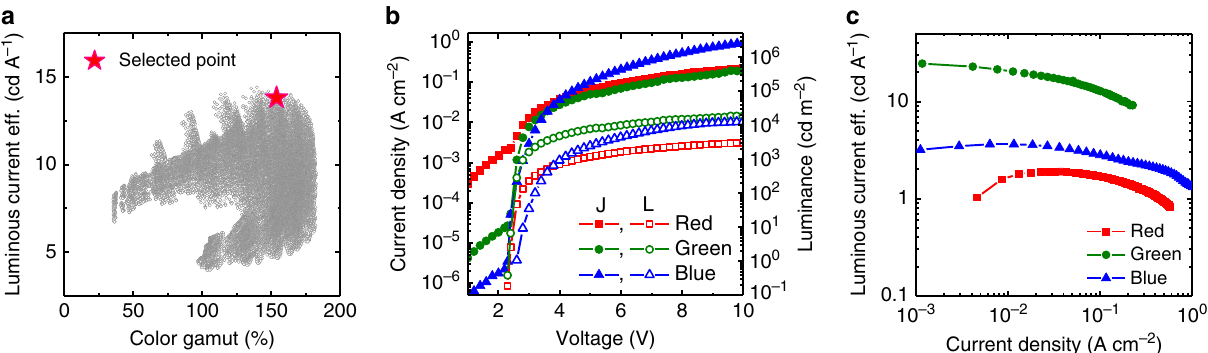
Fig. 3 Optical simulation and characteristics of vertically stacked full-color organic light-emitting diodes (OLEDs). a Optical simulation results with 46,656 points plotted. b Current density ( J) – voltage ( V ) – Luminance ( L ) characteristics, c Luminous current ef fi ciency as a function of current density for independently controlled red, green, and blue OLEDs, in the vertically stacked full-color OLED.